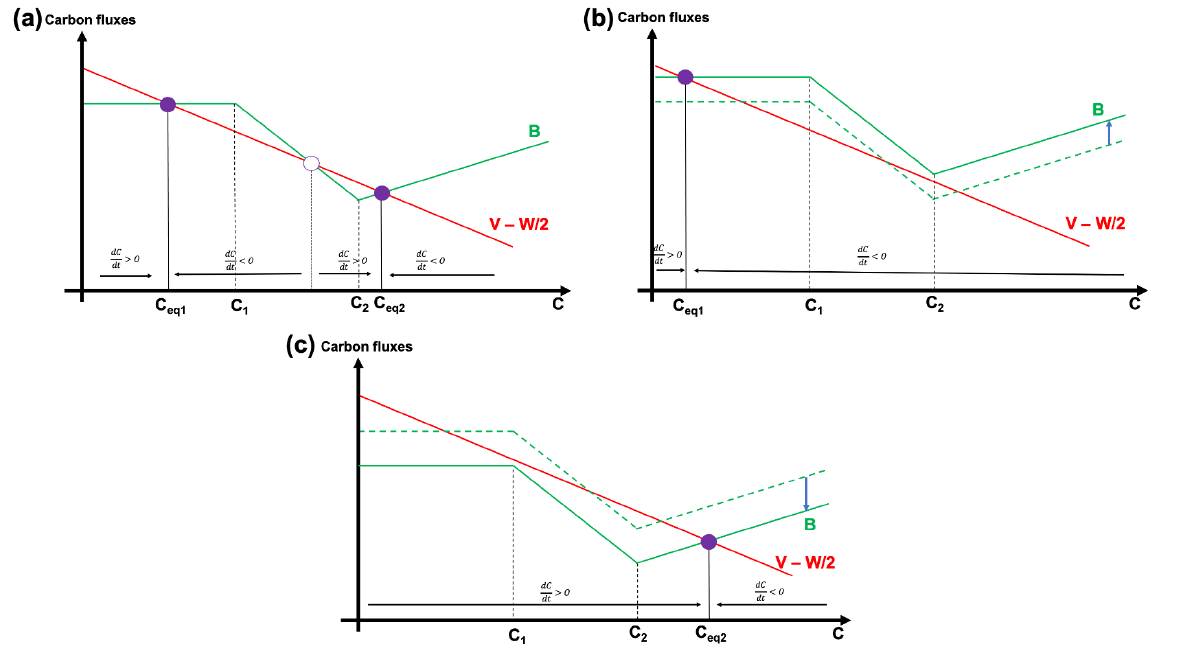
Figure 2. Schematic representation of the organic (green, B) and inorganic (red, V 0 − C / (2 τ c )) terms as a function of the carbon content C. (a) Case of two equilibria in the carbon system (C eq1 and C eq2 ). (b) Case of one equilibria in the carbon system at a low carbon value (C eq1 ). (c) Case of one equilibria in the carbon system at a high carbon value C eq2